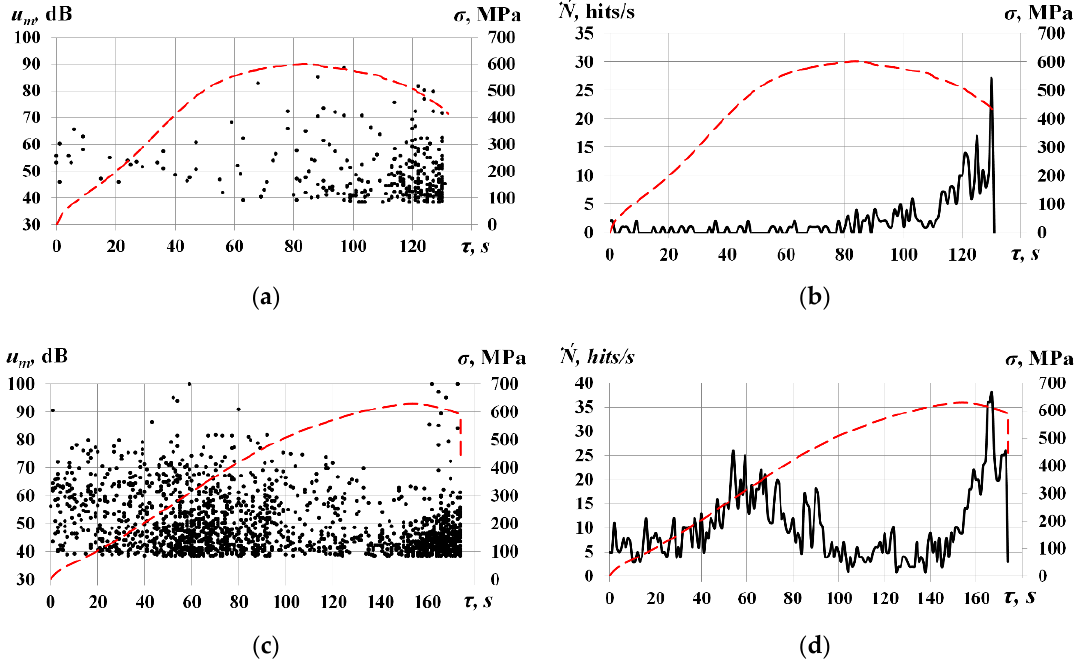
Figure 6. Time dependences of the amplitudes ( u m ) and AE hits rate ( Ń ) of signals during tension testing to failure of specimens with a thickness of 1 mm ( a , b ) and 6 mm ( c , d ).